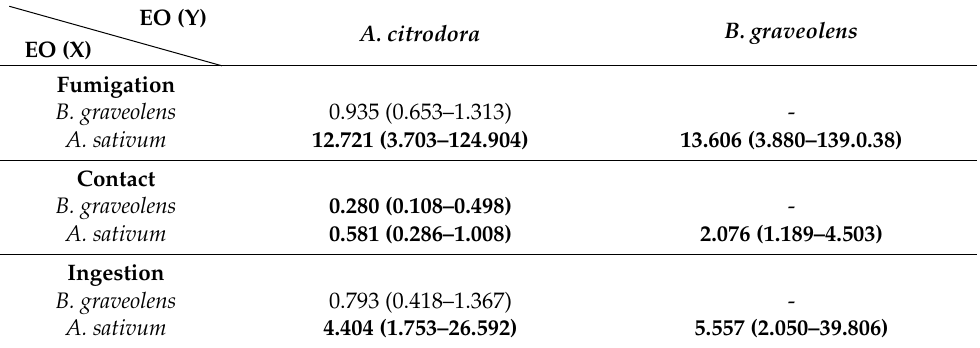
Table 5. Relative toxicity by fumigation, contact, and ingestion of Aloysia citrodora , Bursera graveolens , and Allium sativum essential oils (EOs) to adults of the blowfly Calliphora vomitoria